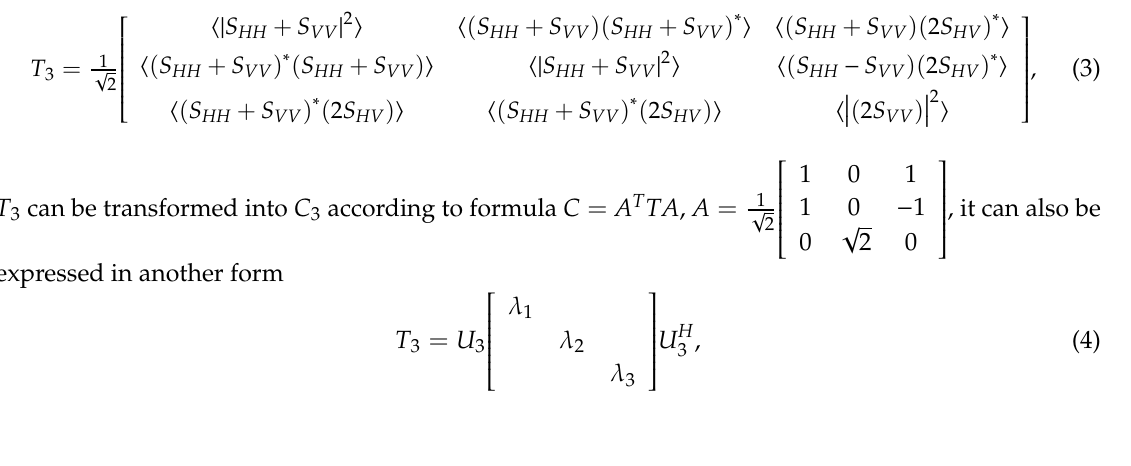
divided into five groups as the position of the box in the figure, each group was input into neural